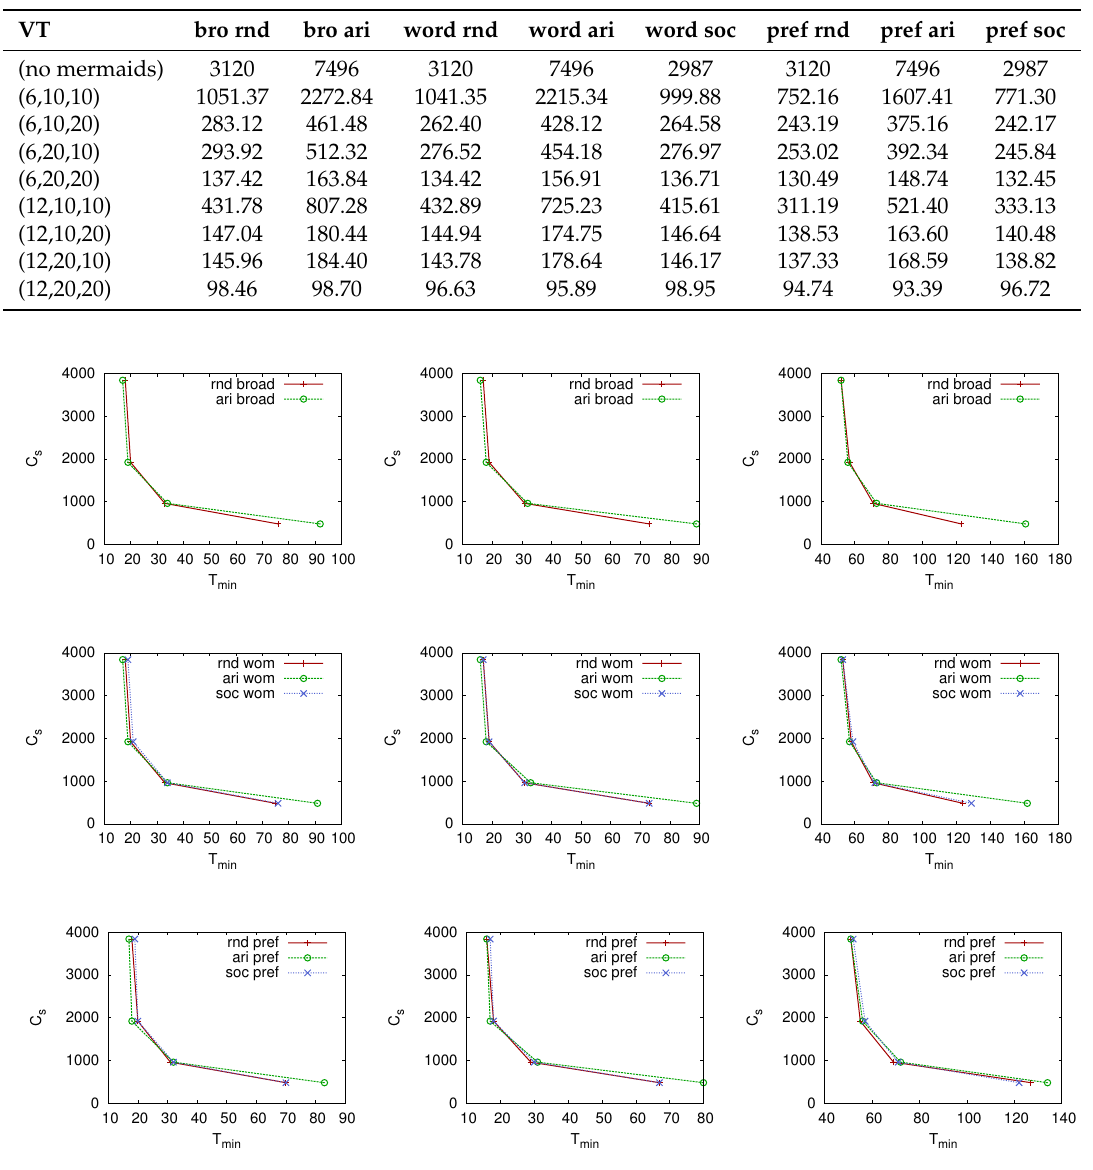
Figure 23. Scatter plots between cost C s and T min in Communities. T min represents the minimum number of steps (in simulated time units) necessary to get the target efficiency ( E glob ). We consider three thresholds: half efficiency (leftmost column), one third (centermost column), and no threshold (rightmost column). Every row represents a different mermaids’ model namely broadcast , word of mouth , and preferential